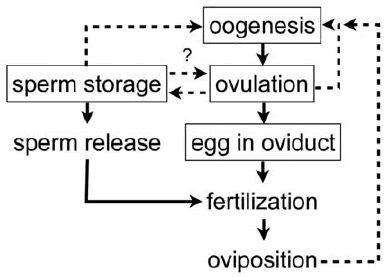
Figure 1. Egg-laying in female insects. Diagram showing the steps involved in egg-laying in female insects (solid lines) and the interactions that may stimulate increased egg-laying (dashed lines). In boxes are steps that may be mediated by seminal fluid proteins. The interaction between sperm storage and ovulation is hypothesized based on the observation that sperm transfer may increase ovulation and sperm depletion, thereby affecting the number of eggs laid. The figure is re- drawn from Bloch Qazi et al.